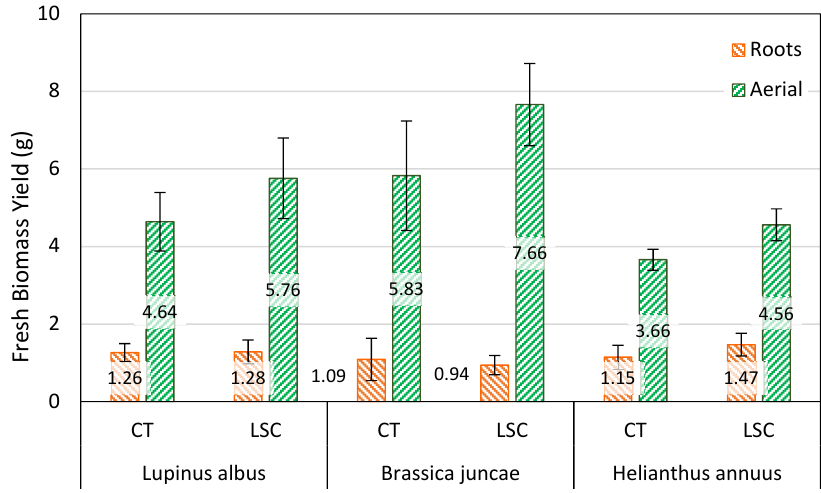
Figure 6. Fresh biomass yield (g) for aerial part and roots. Values are reported as mean ± standard deviation.